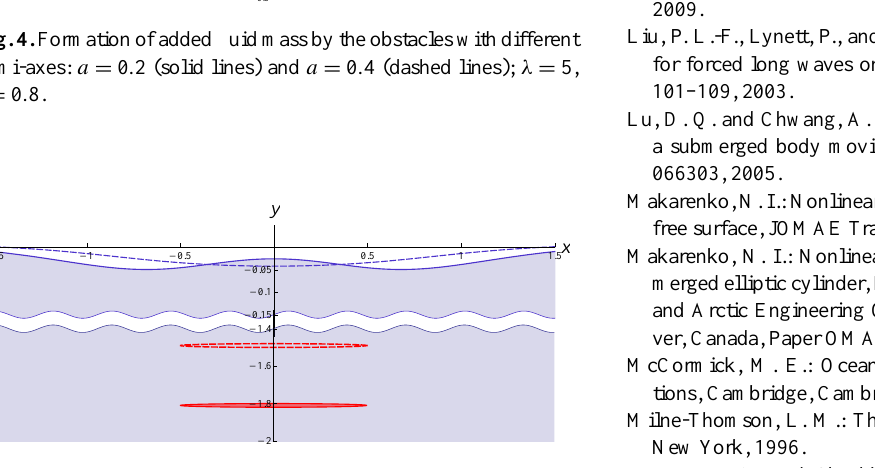
Fig. 5. Formation of splash jets by submersion of the obstacle: a = 0 . 5 , λ = 3 . Position at the time t = 0 . 6 (dashed lines) and t = 0 . 8 (solid lines).